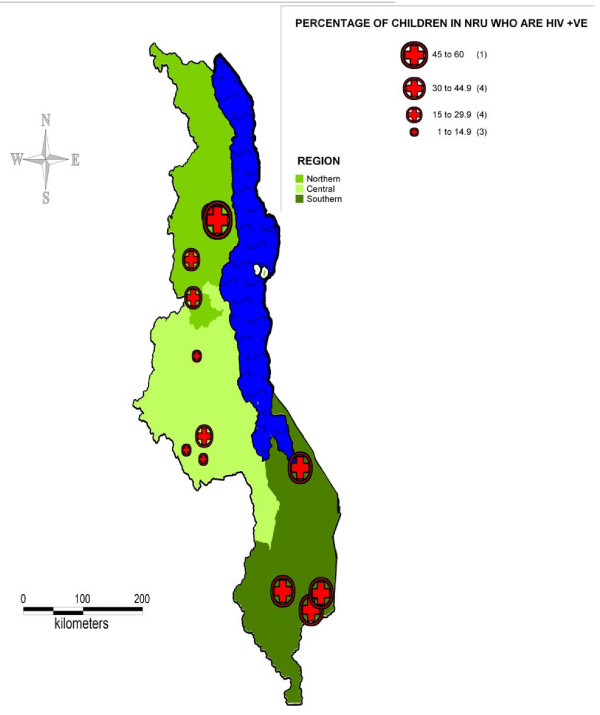
Map of Malawi showing study NRU sites.